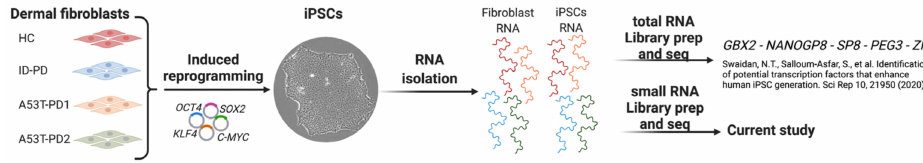
Figure 1. Previous research workflow and results [20]. Using Sendai Virus methodology, we re- programmed four fibroblast lines from participants from whom appropriate written consent was obtained. Reprogrammed iPSC lines formed compacted colonies and exhibited a high nucleus to cytoplasm ratio. Based on immunocytochemistry (ICC) and differential gene expression analysis, all reprogrammed iPSC lines expressed pluripotency markers and were capable of differentiating into cells of all three germ layers. RNA sequences were conducted on the four fibroblasts and their well-characterized and validated iPSC